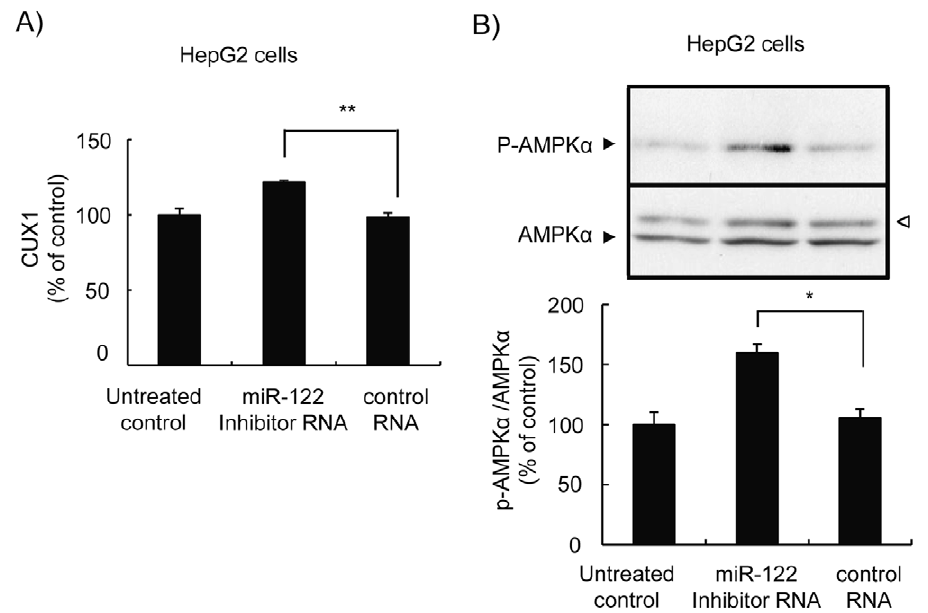
Figure 4. Inhibition of miR-122 induces AMPK activation in HepG2 cells. Cells were transfected either with the miR-122 inhibitor or the control RNA (20 pmol). A , CUX1 mRNA levels 24 h after transfection were determined by quantitative RT-PCR. Data were normalized with respective b -actin and are illustrated as the % of untreated cells (n=3). **, p , 0.01. B , Activated and total AMPK levels 24 h after transfection were determined by Western blot analysis using anti-phospho-AMPK a (Thr 172) and AMPK a specific antibodies, respectively (upper panel). The open arrow head illustrated on the right indicates a nonspecific band. The values obtained from band intensity measurements of the phospho-AMPK a were normalized with those of AMPK a and are illustrated as the % of untreated control (n=3). *, p , 0.05.